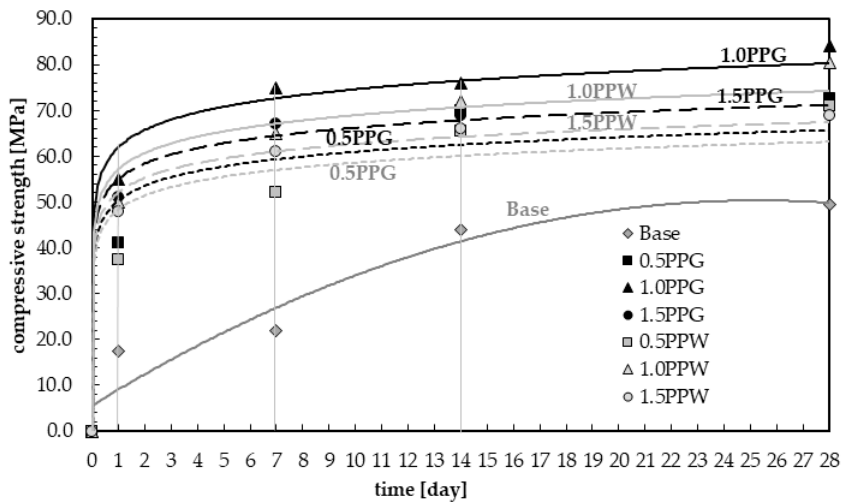
Figure 12. Compressive strength of samples in the function of curing process time with marked times analyzed in this study.